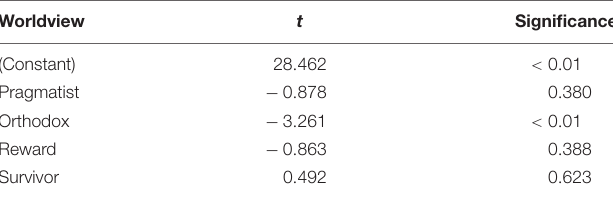
TABLE 9 | Predictors for the state should focus on helping those in need. Worldview t